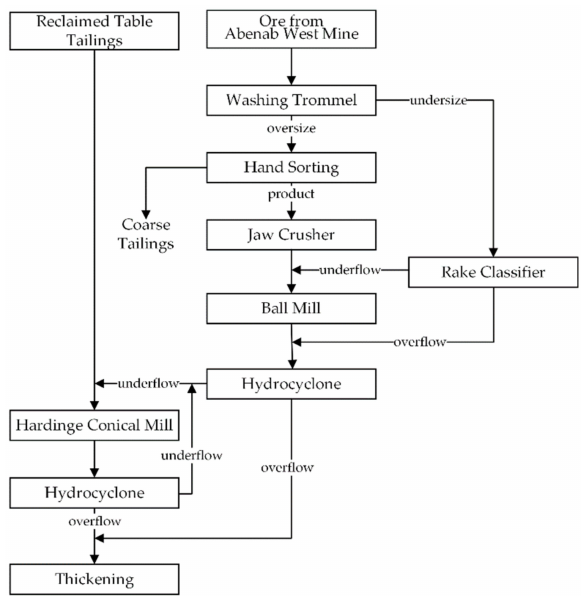
Figure 1. Flowsheet of the processing plant at Abenab West Mine, Namibia, Part 1